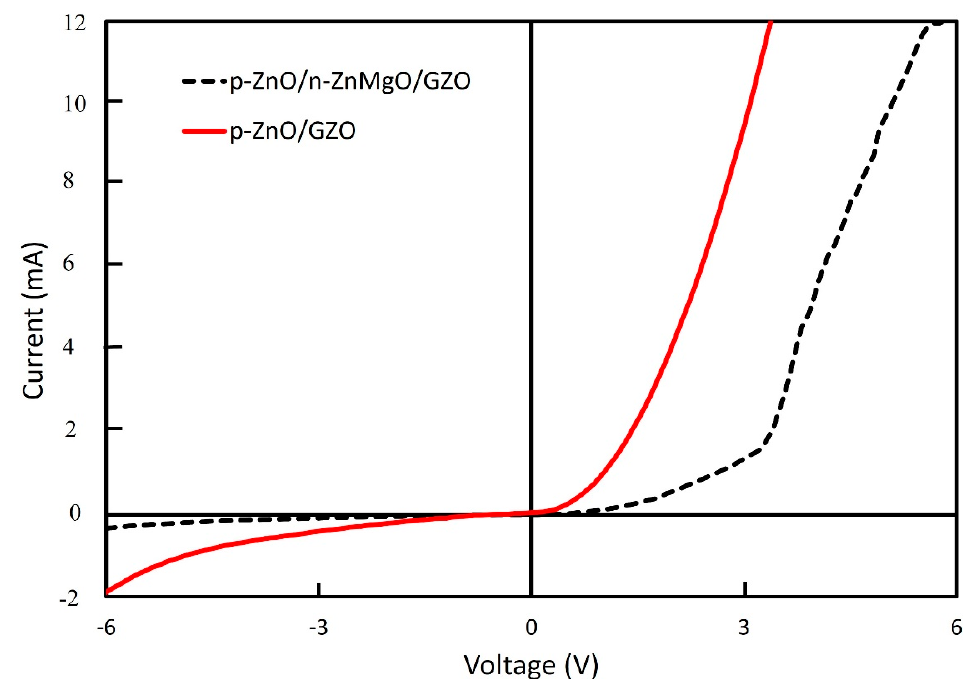
Figure 6. I–V characterization of ZnO NP-based LEDs with the structure of p-ZnO/n-ZnMgO/GZO and p-ZnO/GZO. The EL spectra of the LEDs with p-ZnO/n-ZnMgO/GZO and p-ZnO/GZO structures at room temperature are presented in Figure 7. By inserting the ZnMgO NP energy-barrier layer, the intensity of the EL spectra increased compared to that without the ZnMgO NP layer. In the p-ZnO/GZO structure, holes are injected into the n-type GZO layer. However, the holes injected into the GZO layer do not contribute to luminescence because GZO has a high electron concentration and does not emit light. The p-ZnO layer has a lower hole concentration than the electron concentration in the GZO. The LED with p-ZnO/GZO structure shows a charge imbalance, which means that more electrons are congregated in the p-ZnO layer with holes. The configuration with an inserted ZnMgO layer (p-ZnO/n- ZnMgO/GZO) is a structure that balances the concentration of electrons and holes. The reason for this was that the energy barrier layer blocked the injection of the holes into the n-type layer and increased the concentration of holes in the active region, as shown in Figure 5. As a result, more holes contributed to luminescence in the LED with p-ZnO/n- ZnMgO/GZO structure and enhanced the emission compared to the LED with p- ZnO/GZO structure.